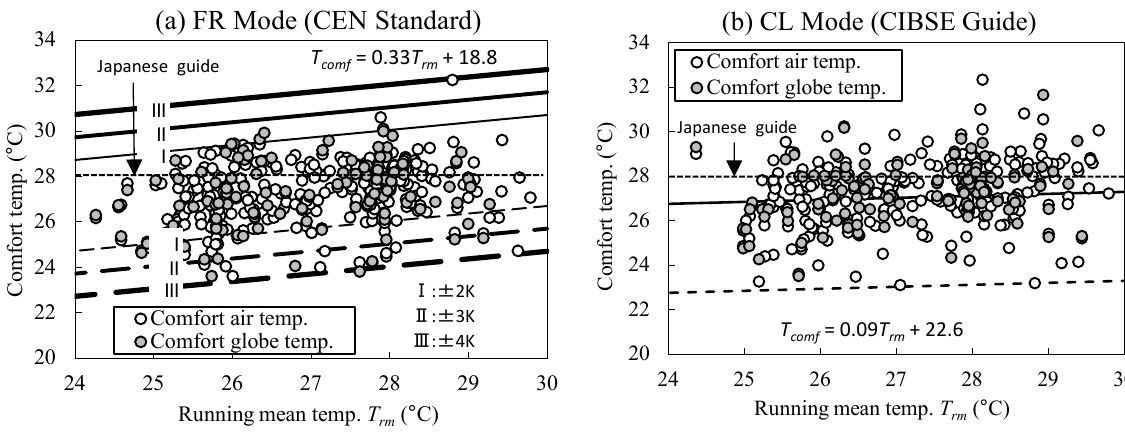
Figure 8. Comparison with the adaptive model: ( a ) FR mode (CEN standard); ( b ) CL mode (CIBSE guide). Each point represents the monthly mean comfort temperature of each subject.